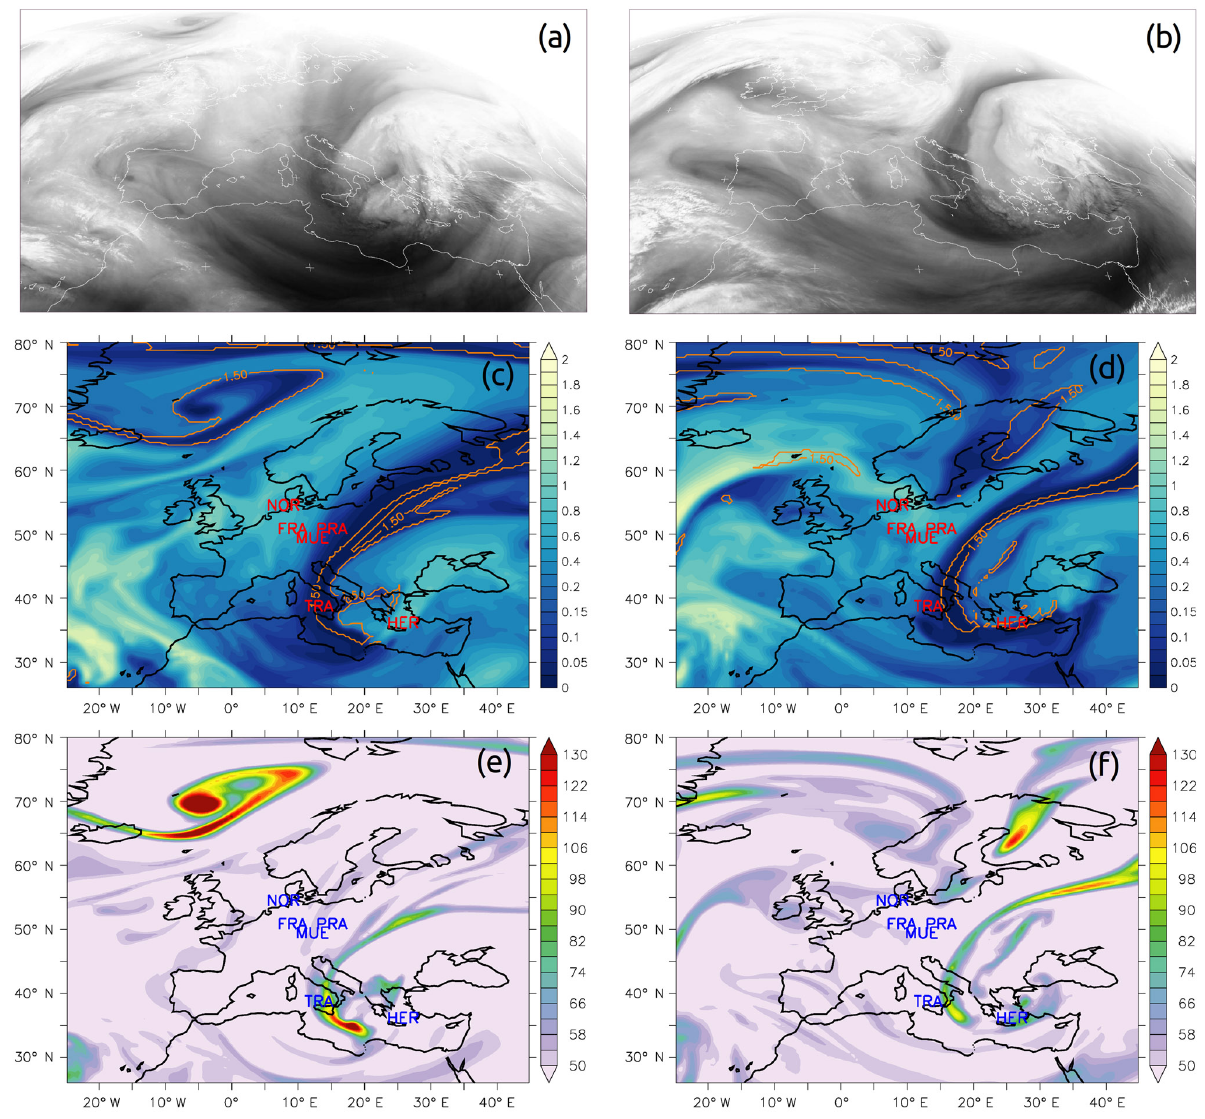
Figure 2. Meteosat water vapour (5.35–7.15µm) satellite images (a, b) , IFS specific humidity (in gkg − 1 ; colour shaded) and PV (1.5pvu; contours) at 500hPa (c, d) , and IFS ozone mixing ratio (in ppb; colour shaded) at 500hPa (e, f) at 12:00Z on 6 January 2017 and 12:00Z on 7 January 2017 respectively. Also shown are the locations of the observational sites (red and blue text) used in the study. Satellite images source: NERC Satellite Receiving Station, Dundee University, Scotland; http://www.sat.dundee.ac.uk/ (last access: 17 March